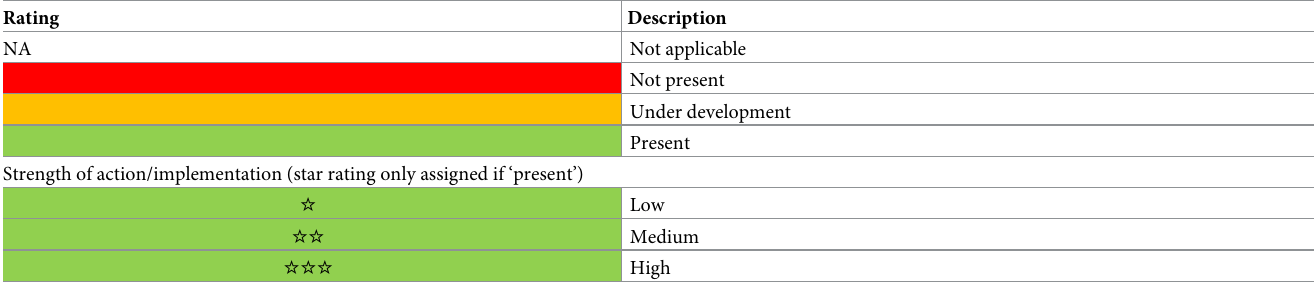
Table 1. Key for indicator ratings for the Pacific MANA dashboard. Rating Description NA Not applicable